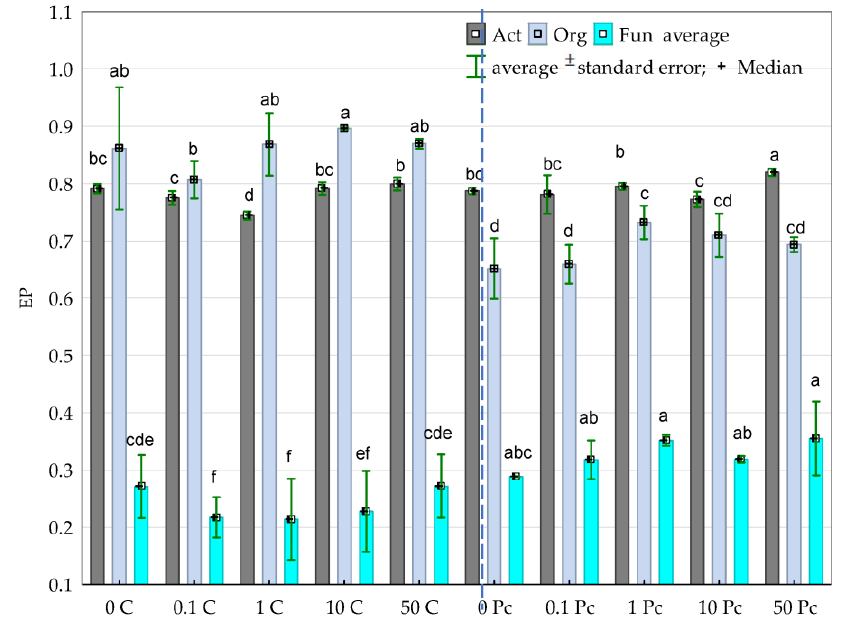
Figure 4. Ecophysiological diversity factor (EP) for Org—organotrophic bacteria, Act—actinomycetes and Fun—fungi in soil contaminated with increasing doses of o -cresol during 15, 30 and 45 days of the experiment (average value); Homogeneous groups denoted with letters (a–f) were calculated separately for each group of microorganisms, 0; 0.1; 1; 10; 50—doses of o -cresol (mg kg −1 DM of soil); C—control; Pc— Perna canaliculus (for abbreviations see Figure 2). The obtained results correspond to the conducted multidimensional PCA analysis, which illustrates the differences in the effect of Perna canaliculus on the microbiological activity of the soil. Its effectiveness in stimulating this parameter was traced using the IF Pc factor (Figure 5). It was found that the first principal component (PCA1), which explains 43% of the total data variance, generated negative values of the vectors of primary varia- bles for fungi (−0.612), similar to most of the analysed bacterial groups, except for nitro- gen-immobilising bacteria (0.541) and ammonifying bacteria (0.425). The dislocation of the cases indicated that on the 15 day of exposure to 10 and 50 mg o -cresol kg −1 DM of the soil, the mussel shells had a positive effect on the number of Azotobacter sp., Pseudomonas sp. and Arthrobacter sp. A spectacularly positive result was also achieved for nitrogen- immobilising bacteria and ammonifying bacteria in pots with the highest o -cresol contam- ination level, on day 45 of the experiment. Of the distinguished phyla, the applied phenolic compound generated the greatest and most varied abundance of OTU for proteobacteria (Figure 6). In control pots, the ob- tained abundance was as follows: day 15–10,500 OTU, day 30–15,585 OTU and day 45– 14,666 OTU. Following the application into the soil of 50 mg o- cresol kg −1 DM of soil, the OTU count decreased by 2%, 5% and 5%, respectively. The second most important phy- lum determining the soil microbiome activity was Firmicutes , which accounted for 22% of the population, irrespective of the study duration. Nevertheless, on days 30 and 45, 50 mg o -cresol kg −1 DM of soil decreased the count of Firmicutes OTUs by 5% and 4% respectively, in relation to the OTU value (6059) obtained on day 15 of the experiment.